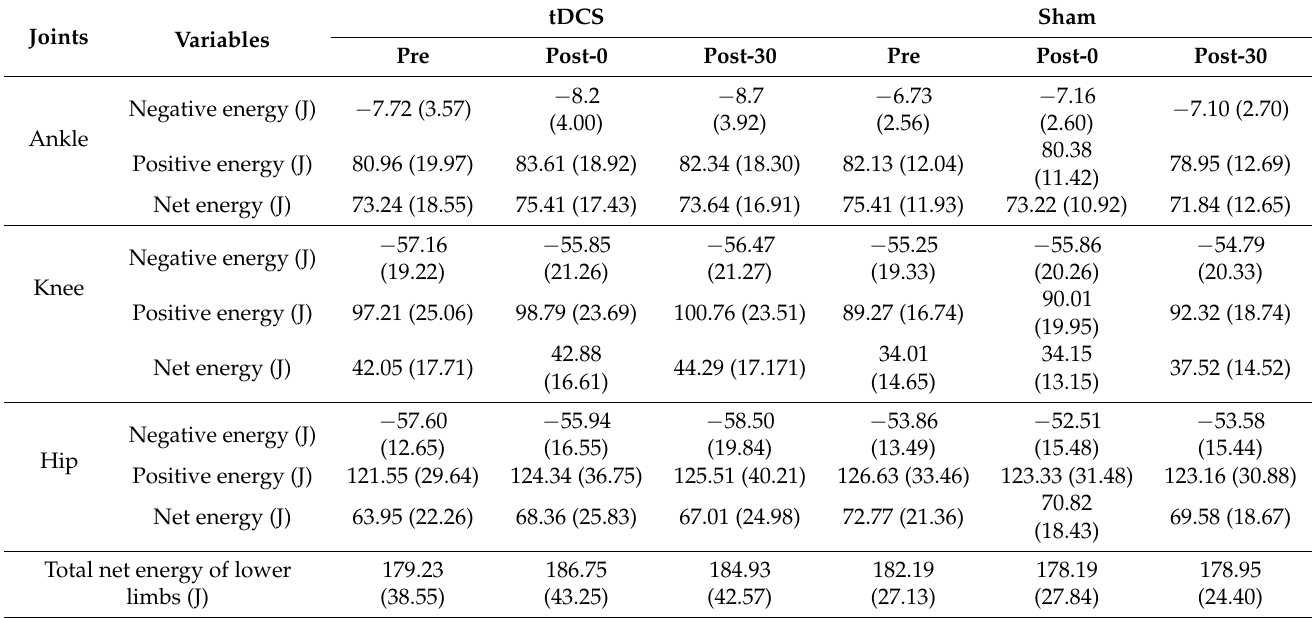
Table 2. Energy of the lower extremities in CMJs ( N = 15, Mean